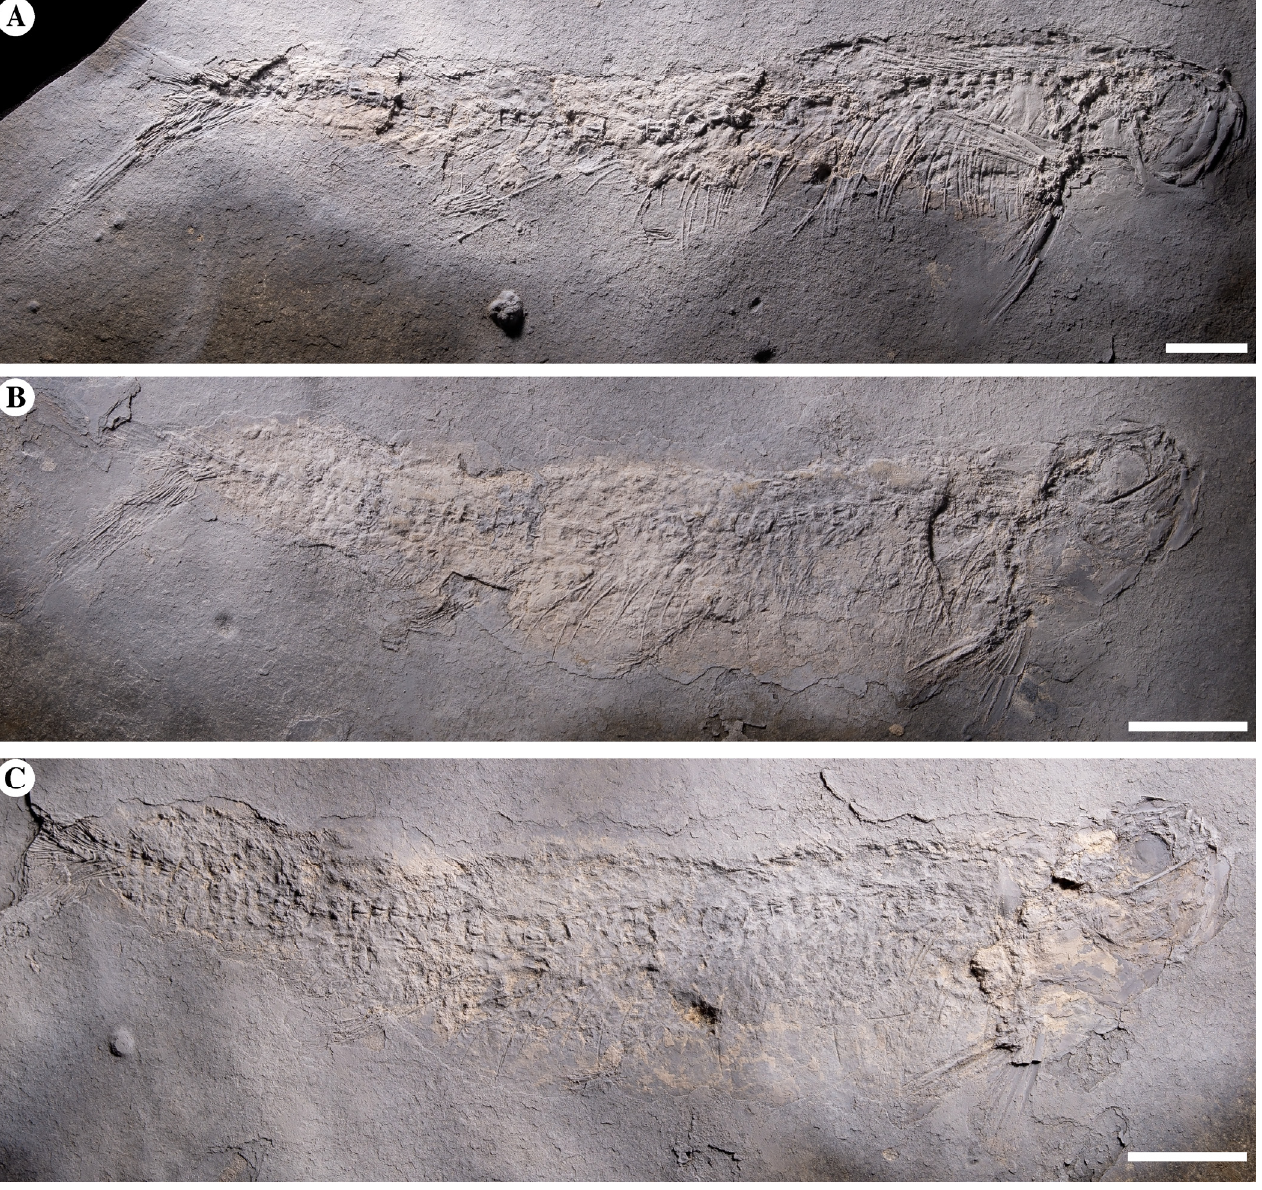
Figure 1. † Cladocynodon araripensis gen. et sp. nov.: ( A ) CFUFMT 139, 231 mm SL. Holotype. Batateira Beds, Barbalha Formation, Araripe basin; ( B ) CFUFMT 432A; ( C ) CFUFMT 432B, part and counterpart of the paratype, 178 mm SL, collected together with the holotype. Ribbon magnesium preparation. Scale bar = 2